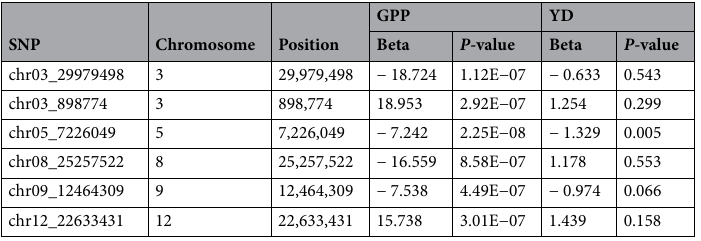
Table 1. Information about instrumental variables. All the SNP markers are named after the chromosome_